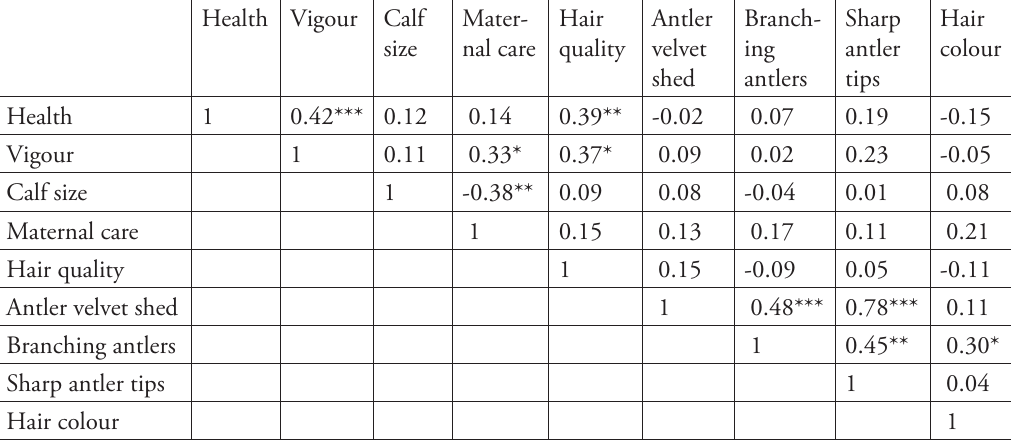
Table 4. Spearman correlations among the scores of selected traits assessed by the interviewed managers of